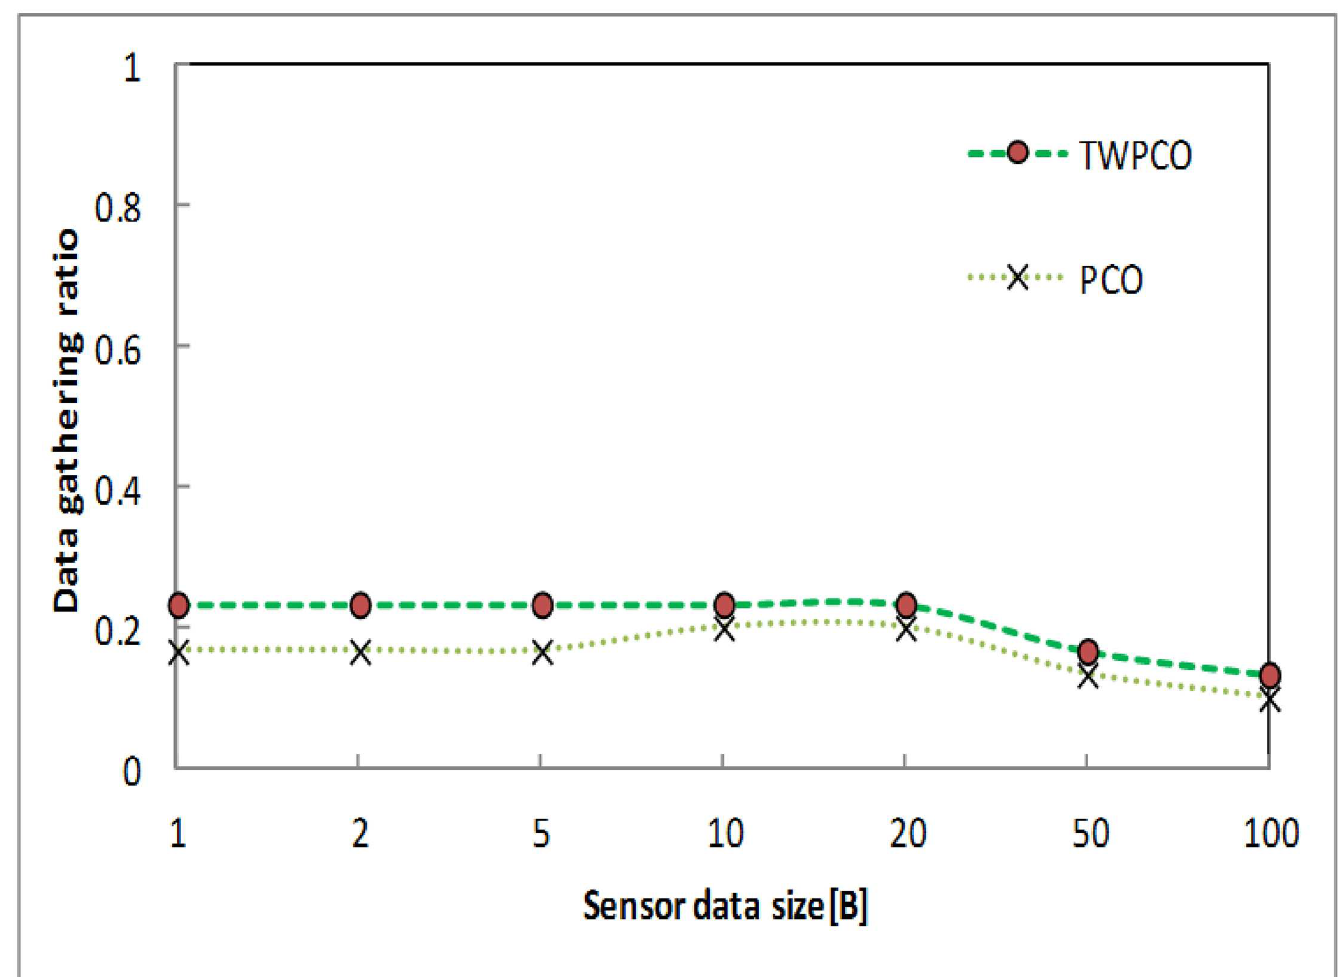
Fig 17. Data gathering ratio based on data packet